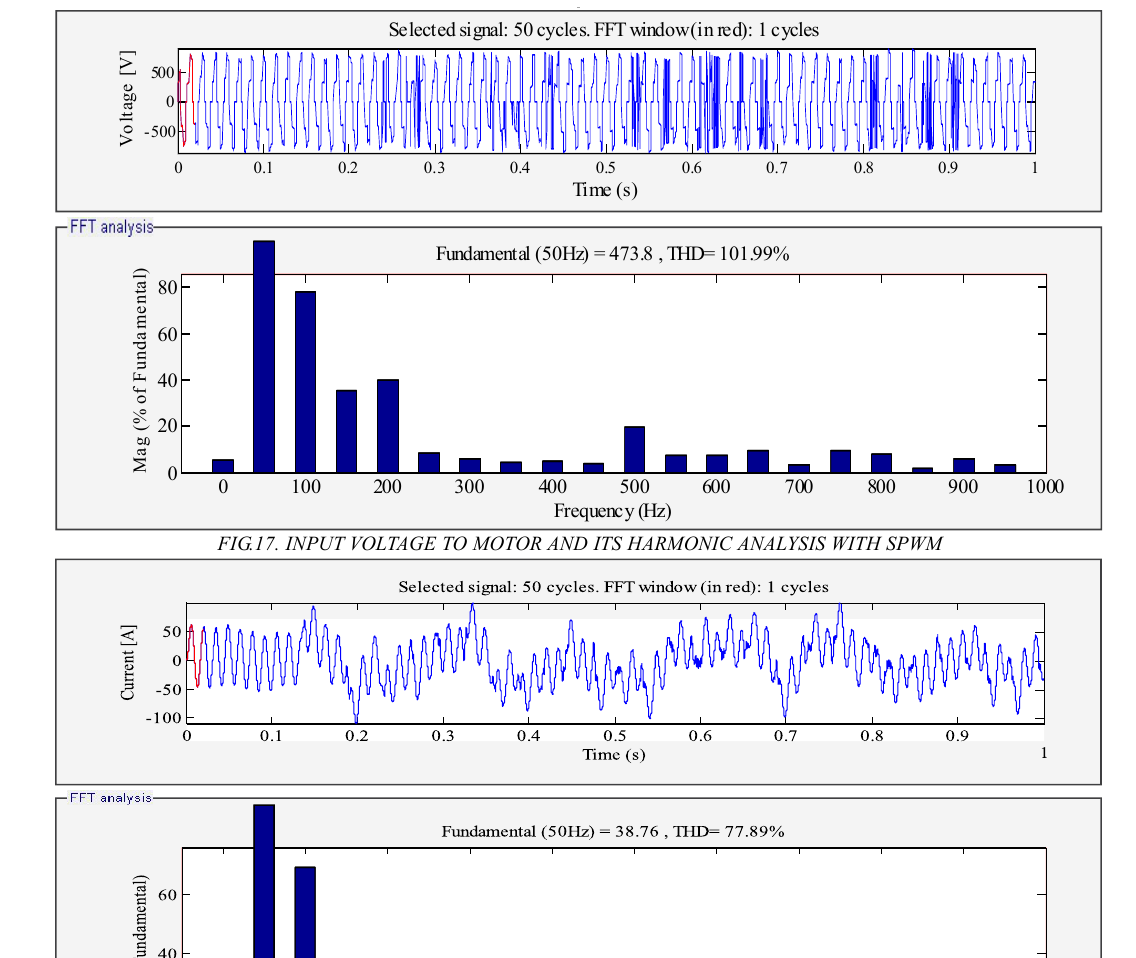
FIG. 18. INPUT CURRENT TO MOTOR AND ITS HARMONIC ANALYSIS WITH SPWM